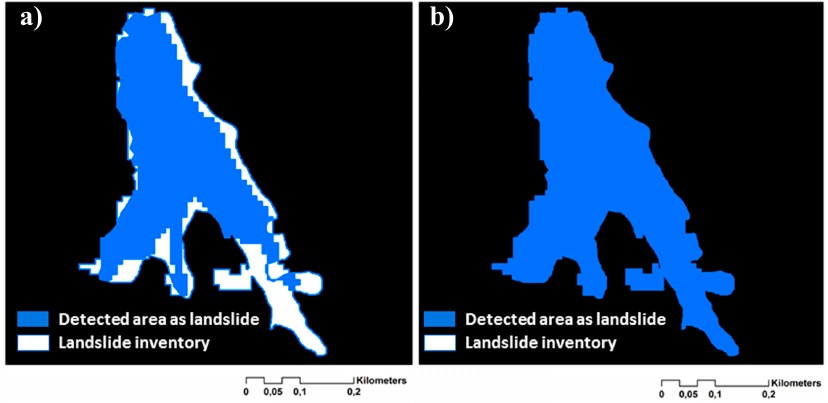
Figure 10. Illustration of the area of overlap ( a ) and area of union ( b ) for a detected landslide as compared to the corresponding area from the inventory data set. Table 3. Landslide detection results for the test zone for the ML and CNN methods trained with two different training datasets of five and eight layers. For CNNs, multiple input window sizes and layer depths were applied. Accuracies are stated as precision, recall, F1-measure, and mIOU.